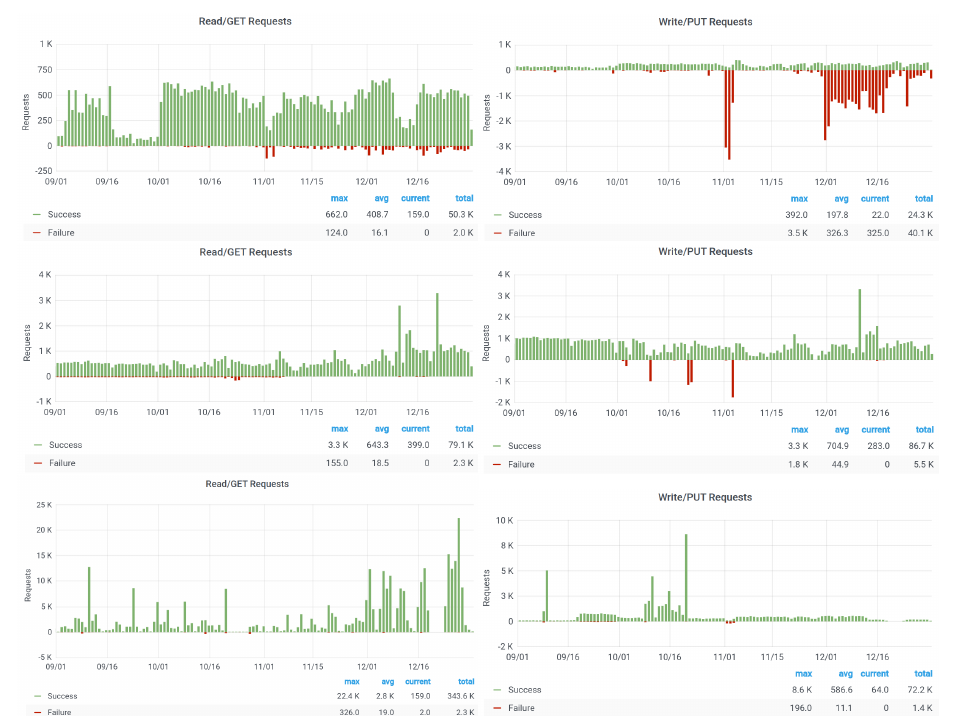
Figure 3: Read (left side plots) and write requests (right side plots) made between Septem- ber and December 2019 through the CERN Dynafed instance (top), the TRIUMF Dynafed instance (middle), and the UVic Dynafed instance (bottom). The two instances for